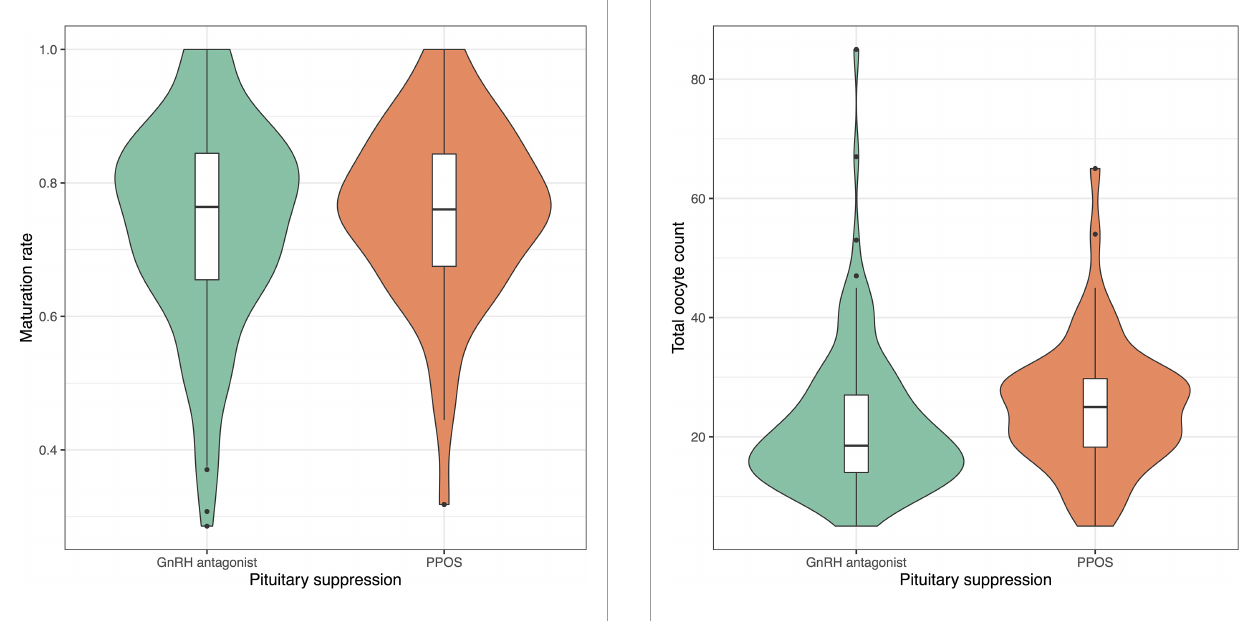
FIGURE 3 | Violin plots showing total oocyte count in cycles suppressed with GnRH antagonists (green) and progestins (orange). Colored shaded areas show the distribution density. Lower and upper bounds of box plots show the interquartile range, and horizontal dash shows the median. Black dots show potential outliers. GnRH, gonadotrophin releasing hormone; PPOS, progestin primed ovarian stimulation.